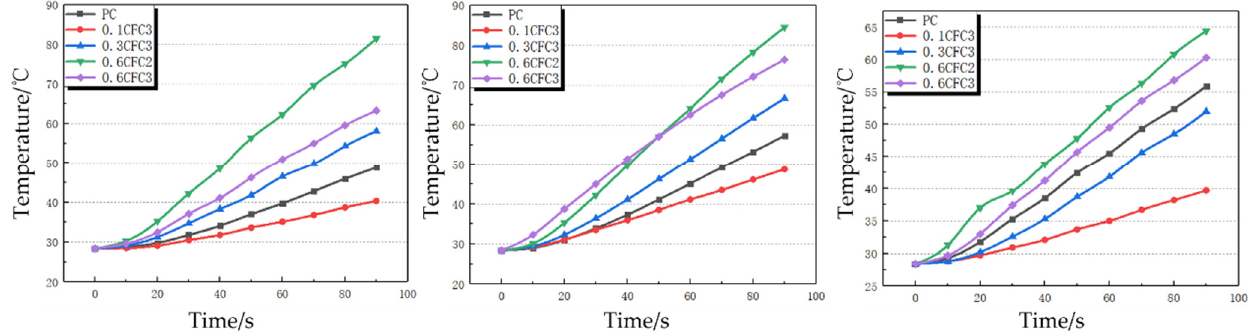
Figure 5. Temperature increase curve at the center point (T 0 ) of modified concrete samples with different carbon fiber contents and lengths.